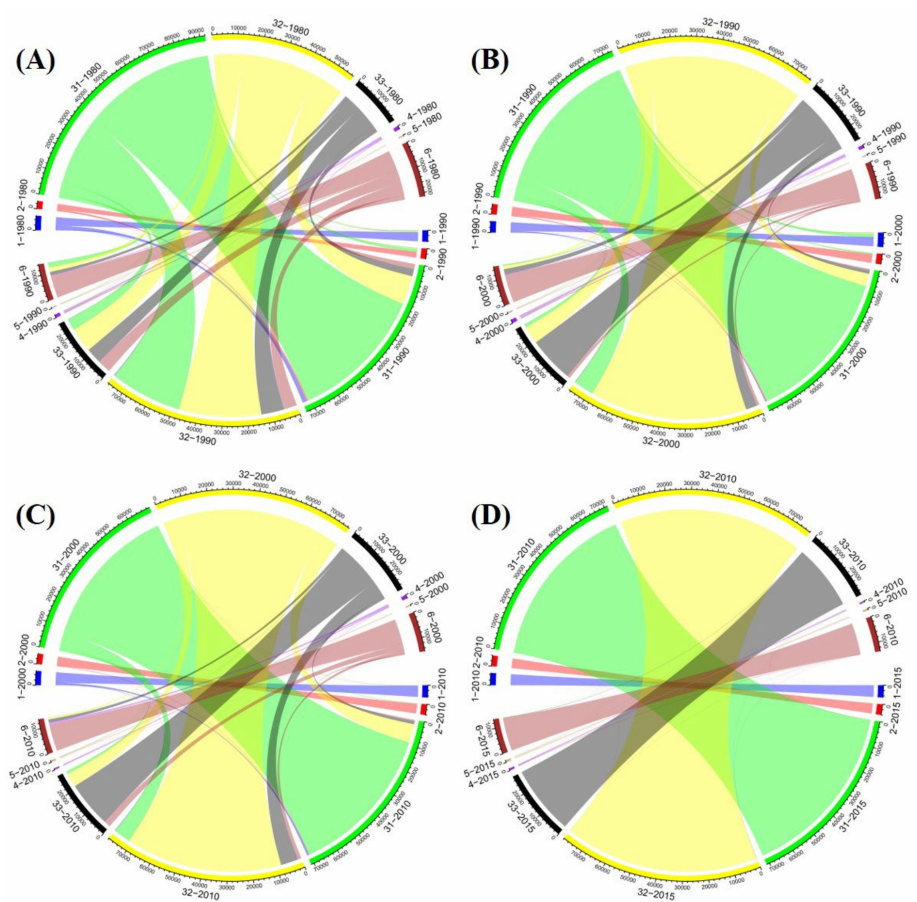
Figure 3. Network structure LULC transfer matrix for the study area between 1980–1990 ( A ), 1990–2000 ( B ), 2000–2010 ( C ), and 2010–2015 ( D